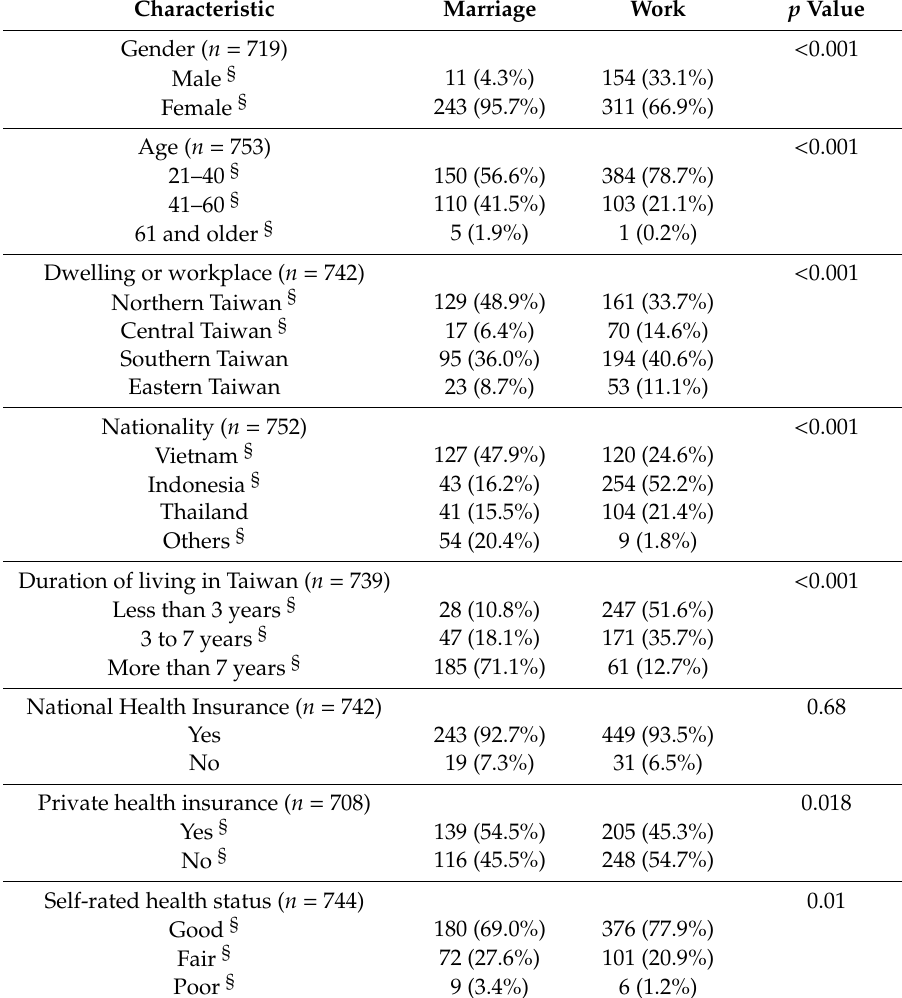
Table 1. Demographic characteristics of the study population, stratified by reasons for migrating to